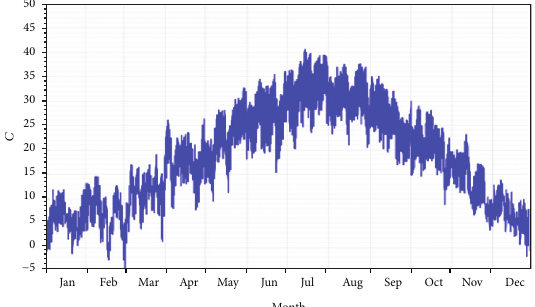
Figure 6: The average temperature of Tehran in di ff erent months of the year [http://www.tehranmet.ir/].